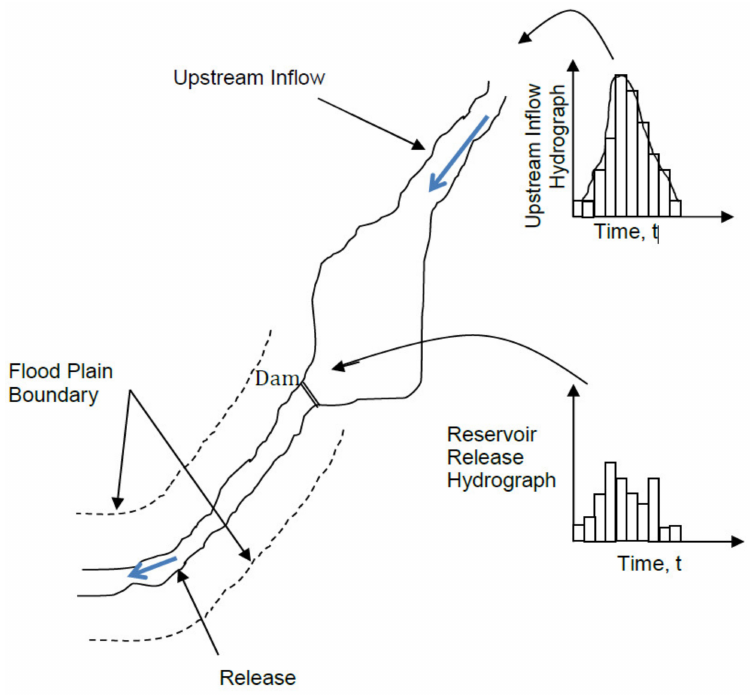
Figure 1. Schematic of a River-Reservoir